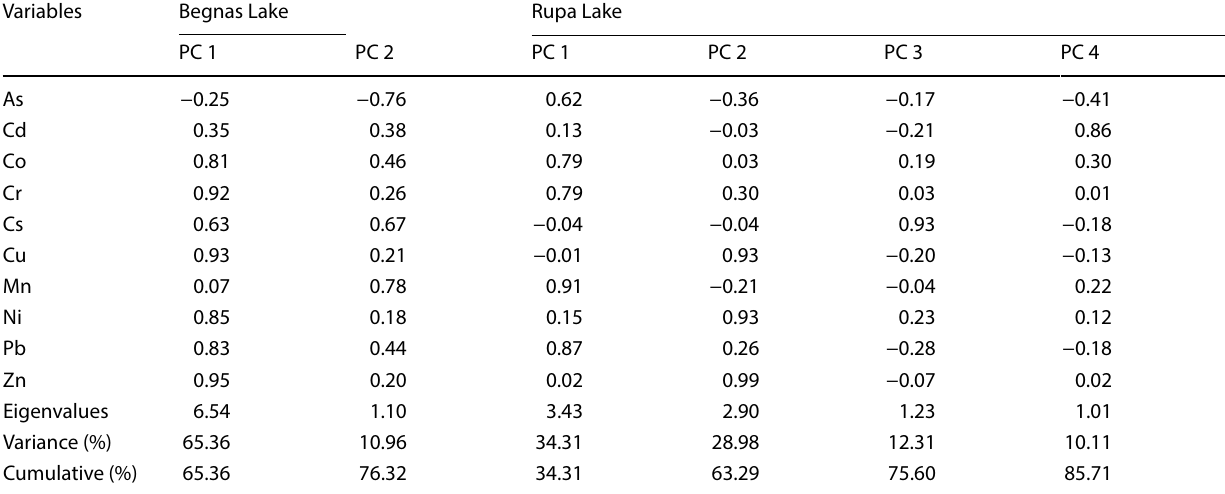
Table 3 Factor loadings table of principal component analysis (PCA) of Begnas and Rupa Lake, Gandaki Province, Nepal